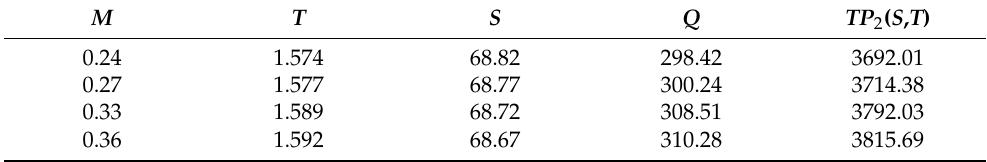
(cid:0) (cid:1) I g .